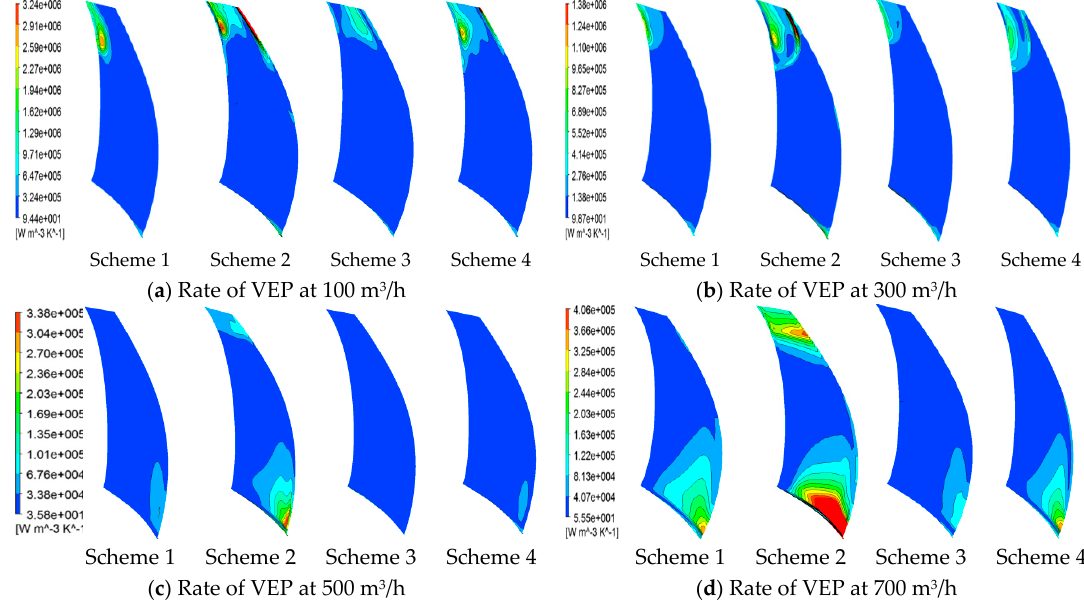
Figure 14. Rate of VEP at various flow conditions [24].